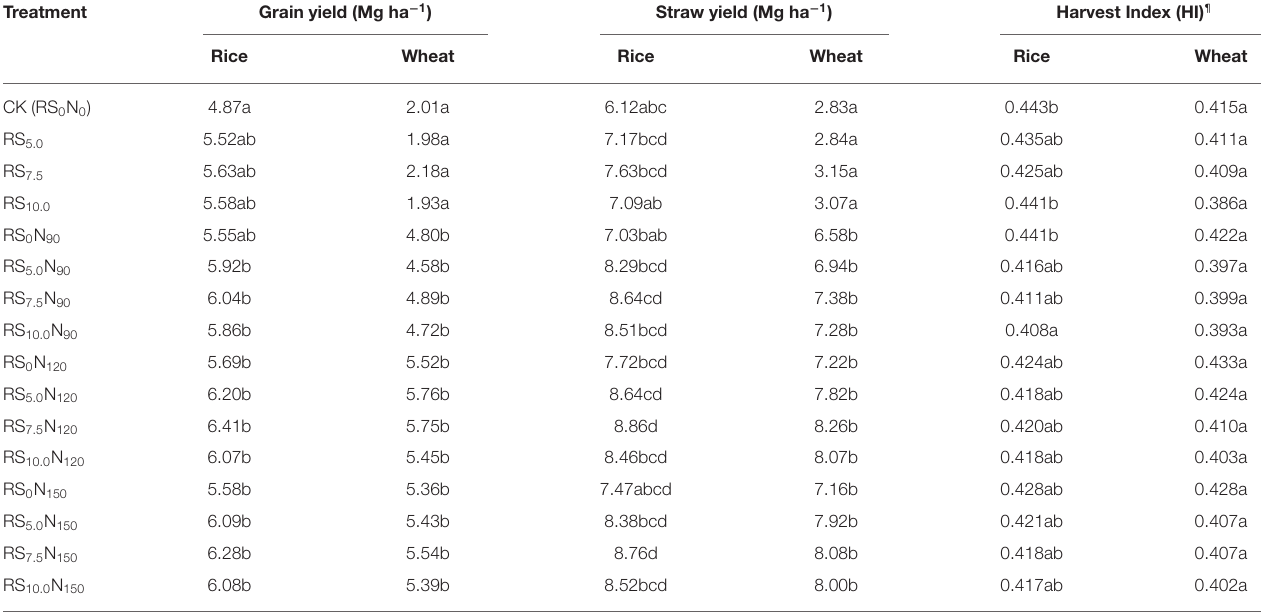
TABLE 1 | Effect of fertilizer-N application and rice straw (RS) incorporation on grain and straw yield and harvest index (HI) of rice and wheat in a sandy loam soil under rice-wheat cropping system ( data pooled for 4 years ) in north-western India. Treatment